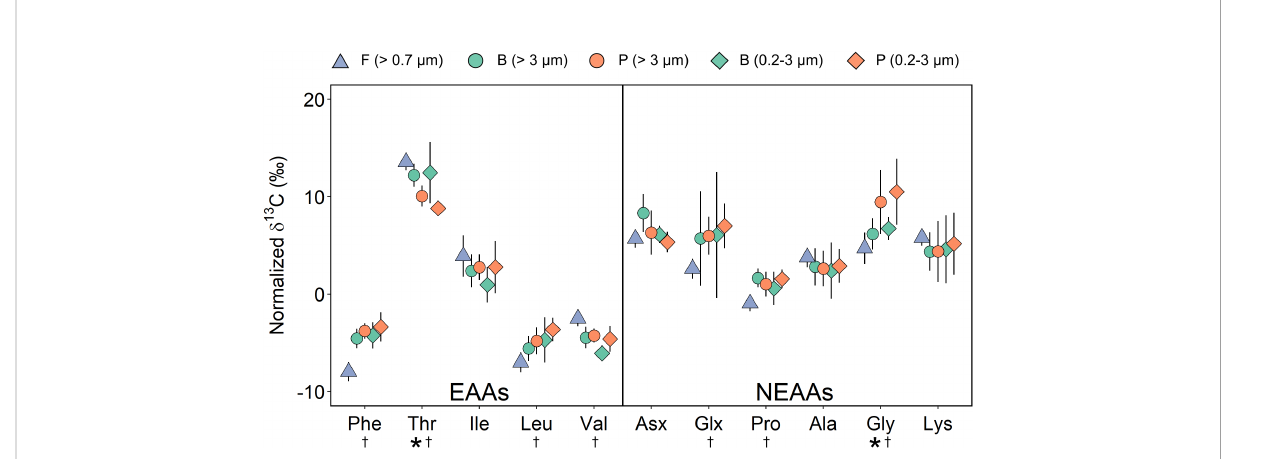
FIGURE 2 Normalized d 13 C-AA values of pelagic algae (P) and sea ice algae from the fast ice (F) and brash ice (B). Error bars show ±1 standard deviation for each group (n = 5-9). Asterisks indicate signi fi cant differences between brash ice algae and pelagic algae for both sizes (Two Sample T-test, p < 0.05). Daggers indicate signi fi cant differences between fast ice algae and pelagic algae for both sizes (Two Sample T-test, p < 0.05). EAAs, essential amino acid; NEAAs, non-essential amino